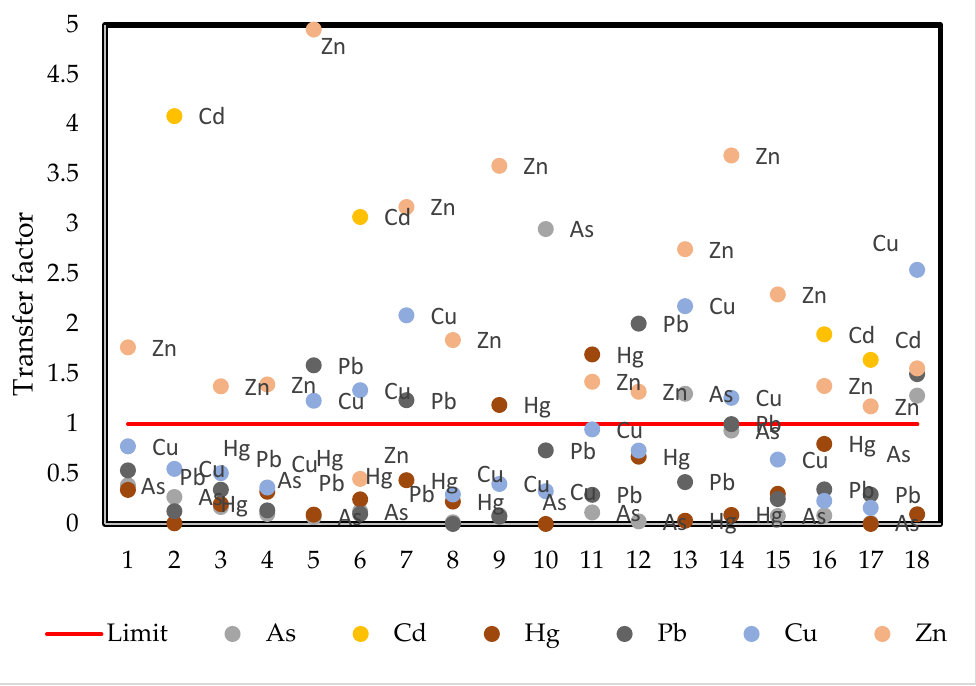
Figure 5. Transfer factor for leaves-soil. The red line represents the limit above which metals are observed to be able to be transferred in the plant.